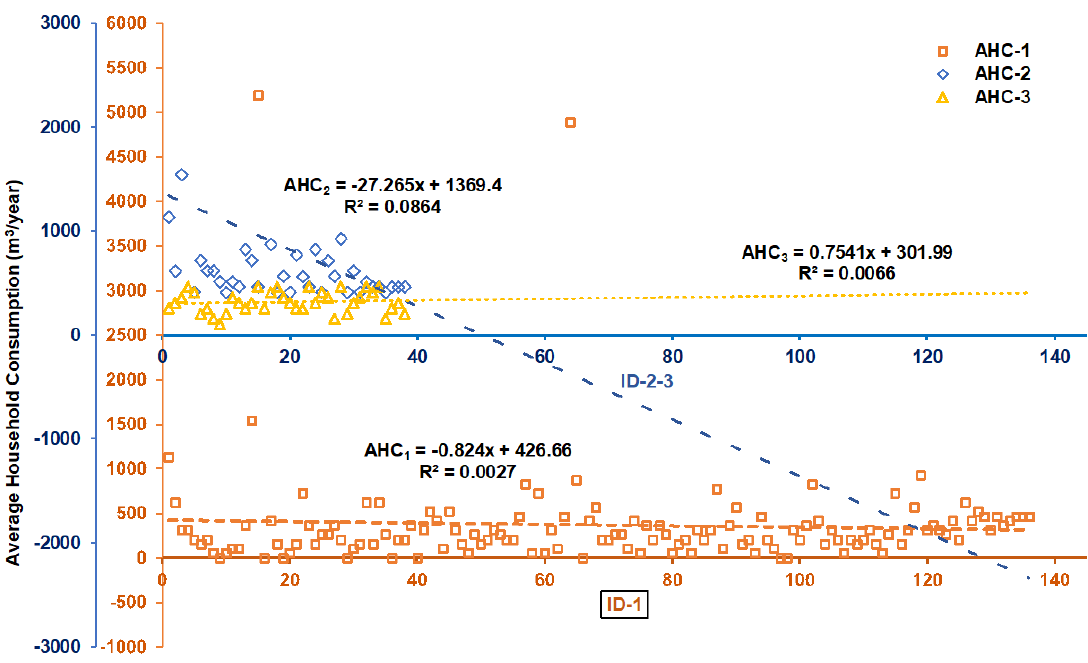
Figure 3. Average customer consumption outcomes for the pre- and post-retrofitting process.